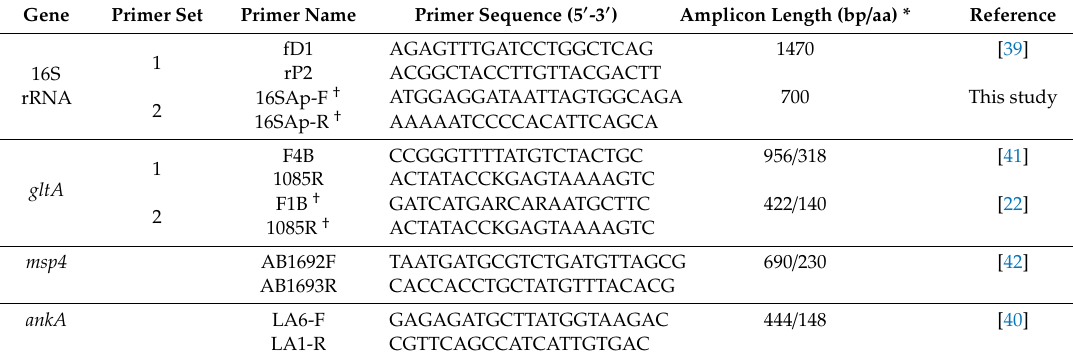
Table 2. Primers used for amplification of four Anaplasma